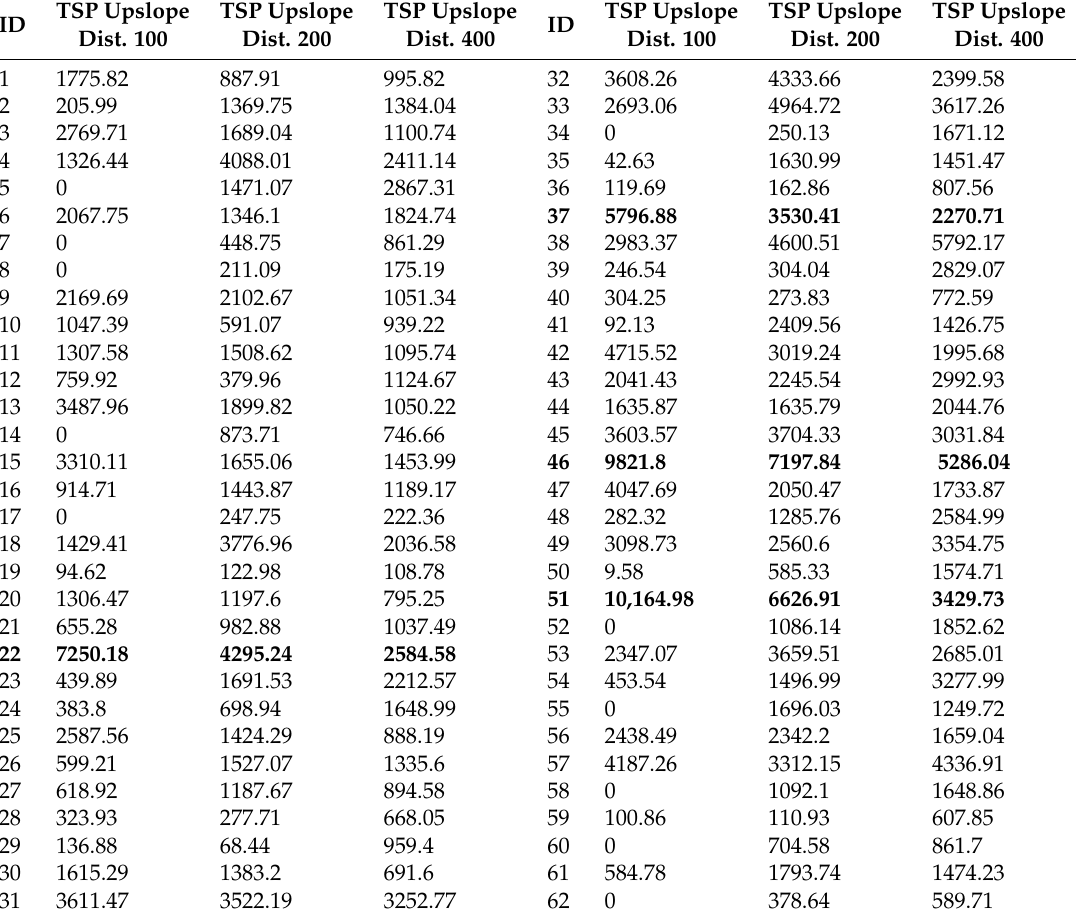
Table 2. Values for the total stream power corresponding to the 62 cross-sections along the Topino River, expressed in W/m. Values in bold correspond to the highest values of